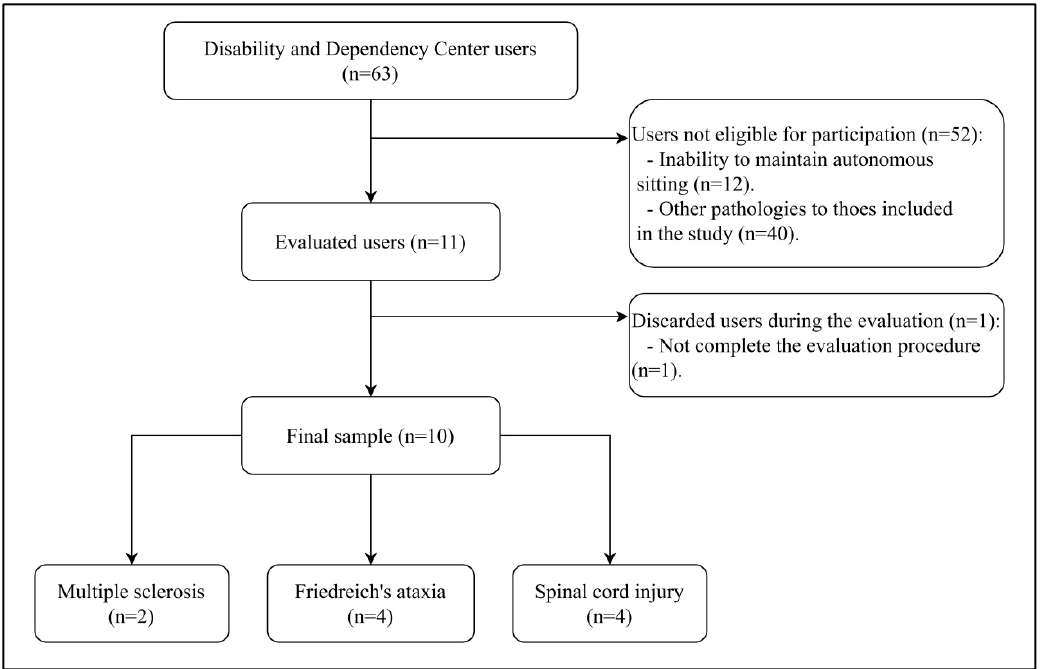
Figure 1. CONSORT flowchart diagram.